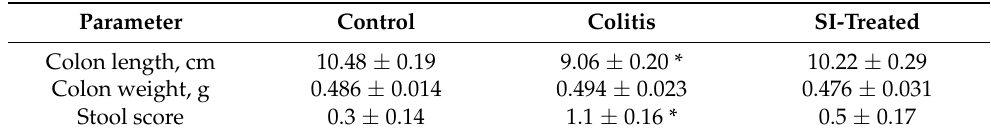
Table 1. Colonic changes including the measured colon length, colon weight, and stool score were analyzed as described in the Materials and Methods. Data are presented as mean ± standard deviation (n = 10 per group, * p < 0.05 vs. control, ANOVA). Parameter Control Colitis SI-Treated Colon length,